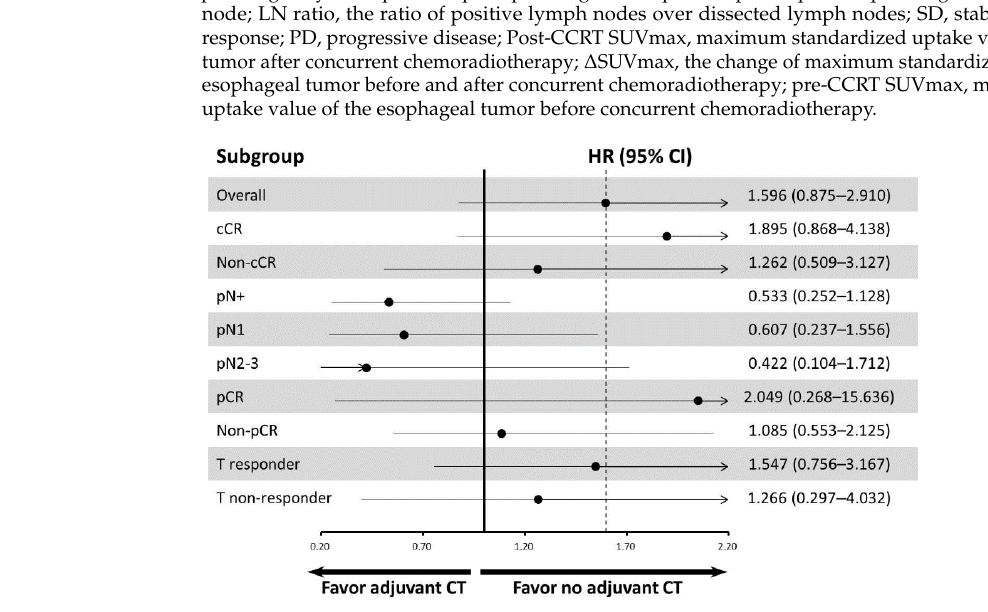
Figure 1. Forest plot for subgroup analysis of overall survival. Abbreviations: 95% CI, 95% confi- dence interval; adjuvant CT, adjuvant chemotherapy; cCR, clinical complete response; HR, hazard ratio; pCR, pathological complete response; pN+, pathologically node-positive; T responder, the pa- tients with downstaging by T classification.